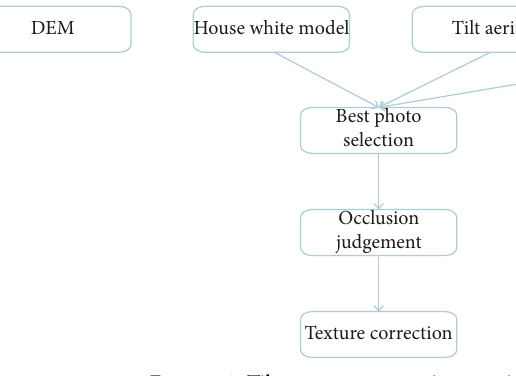
Figure 4: Tilt texture automatic mapping process. Table 2: The recorded altitude of five